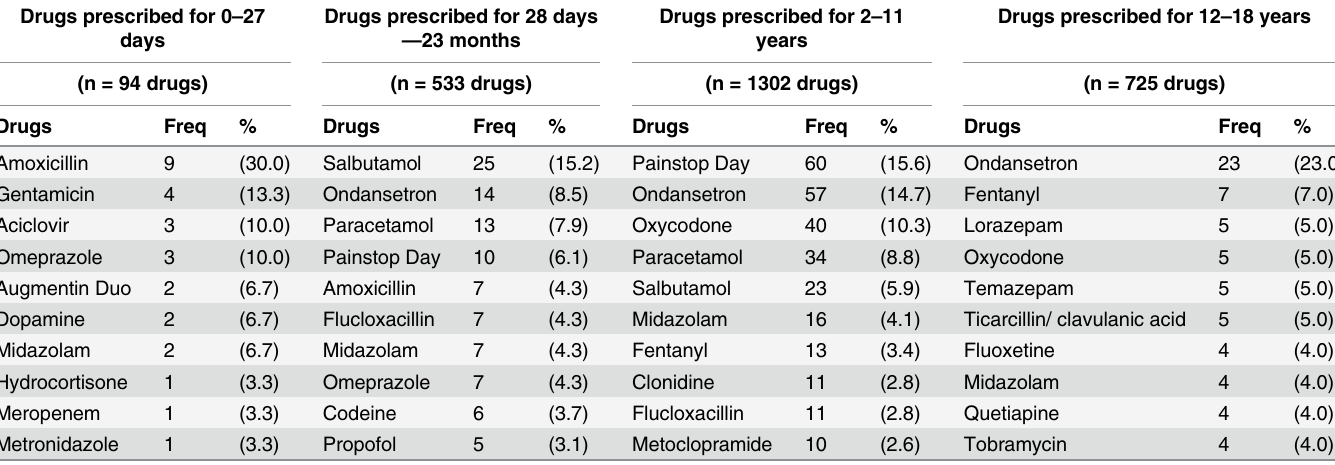
Table 5. The ten most common off-label drugs prescribed to different age groups. Drugs prescribed for 0 – 27 days